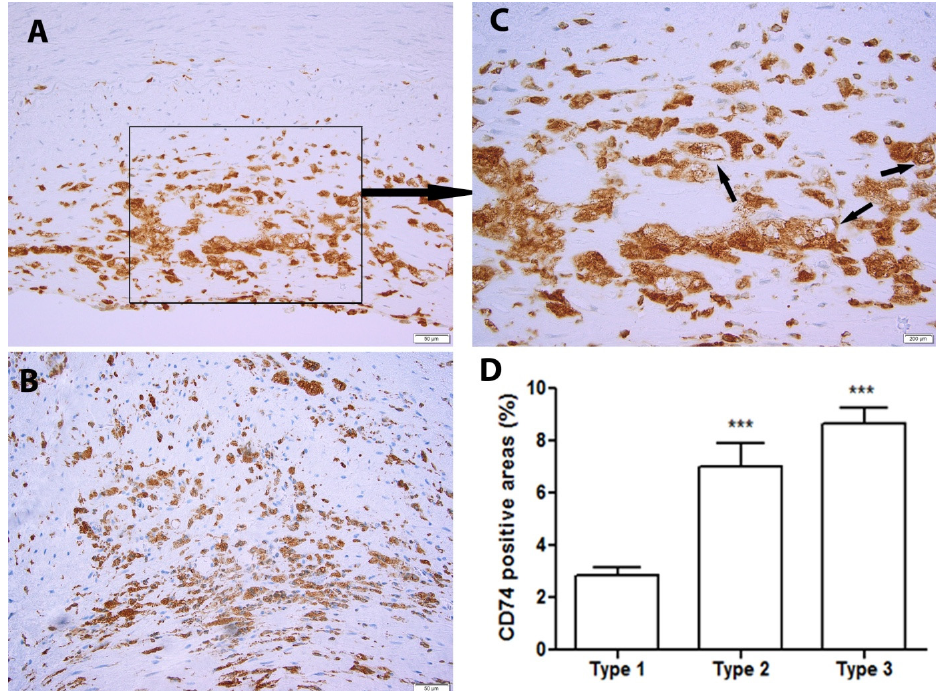
Figure 1. CD74 levels are significantly related to the severity of the atheroma plaque. Representative images of type 1 lesions ( A ), the squared area is shown in C with higher magnification and type 2 lesions ( B ). ( C ) An enlarged area from A indicate cell surface expression of CD74 (arrows). Image analysis of CD74 ‐ positive areas in type 1 ( n = 47), type 2 ( n = 33), and type 3 ( n = 59) plaques ( D ). *** p < 0.001 vs. type 1 plaques.